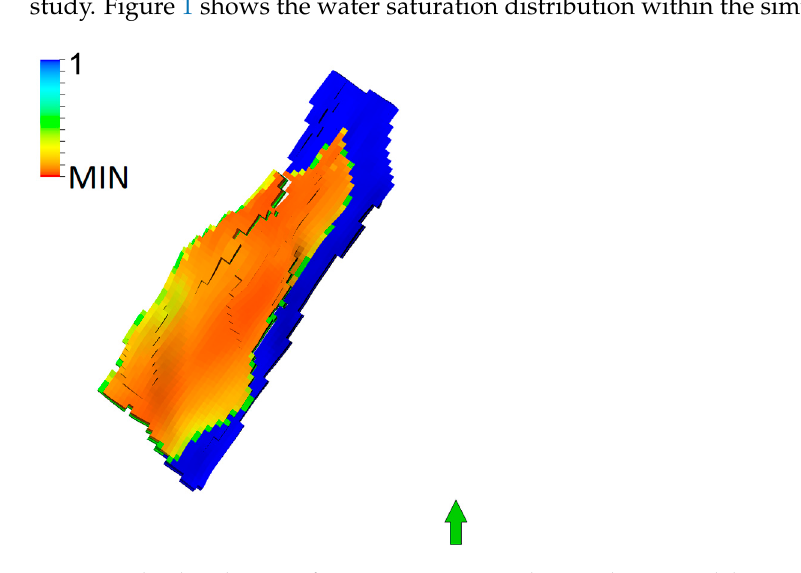
Figure 1. The distribution of water saturation in the simulation model. Source: PGNiG Upstream Norway AS.